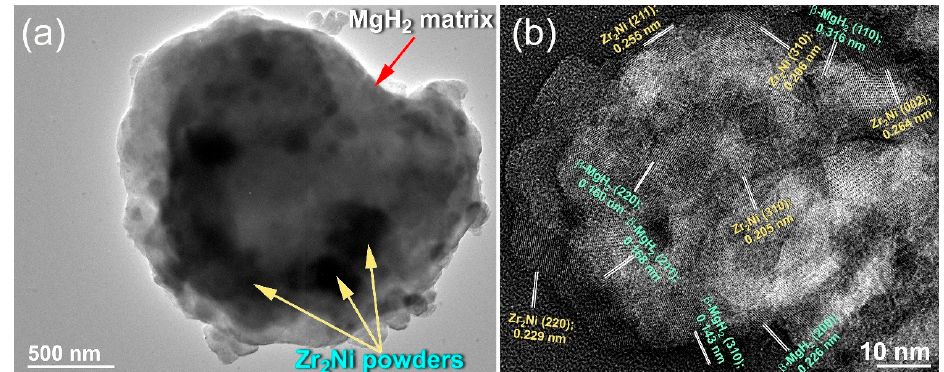
Figure 5. ( a ) Bright field image (BFI) of Mg powders doped with Zr 2 Ni particles and milled for 50 h